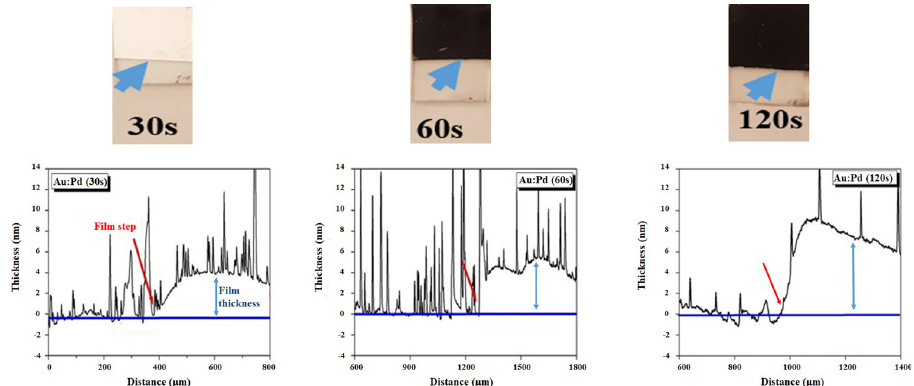
Fig 3. Optical images of the Au:Pd 80:20 coatings sputtered on soda-lime glass for 30 s, 60 s and 120 s (s: Seconds) with correlative profilometry measurements after 30 s, 60 s and 120 s sputter-coated by Au:Pd films approximately 4 nm, 5 nm and 8 nm thick. The glass level, which refers to the soda-lime glass, is indicated by the blue baseline, with the film step and thicknesses indicated by red arrows. The film step refers to the sputter-coated material and the red and blue arrows correspond with each other and indicate the same place where the coating has taken